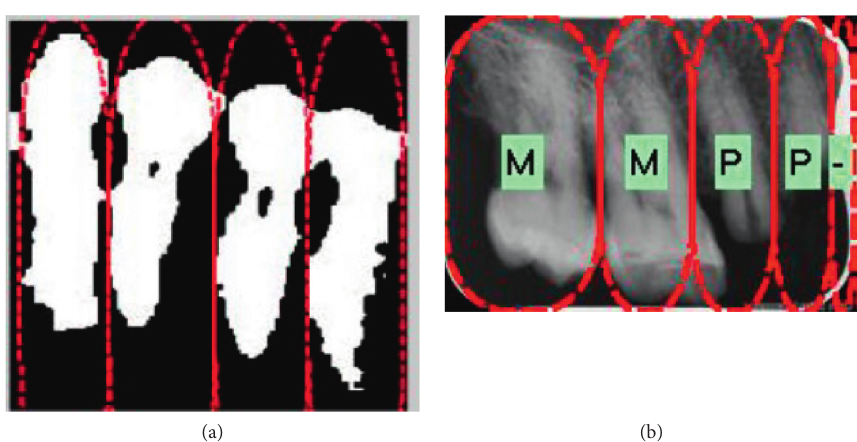
Figure 7: (a) Horizontal integral projection of lower tooth; (b) classification result